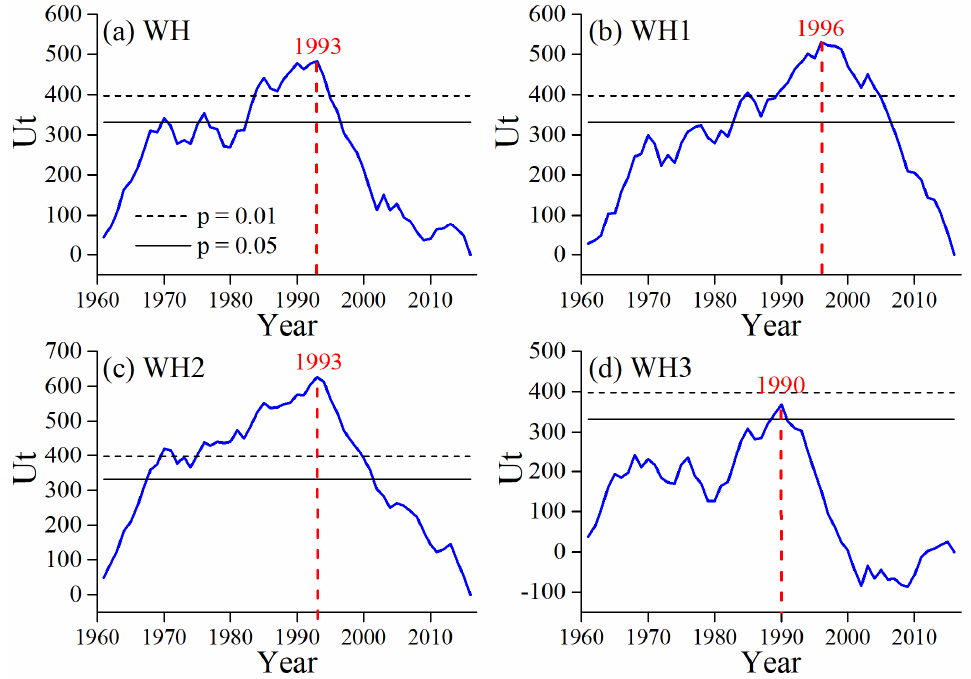
Figure 7. Ut statistic of Pettitt test used for detecting a change-point for annual runoff of ( a ) the Weihe River basin (WH) and the three sub-regions, i.e., ( b ) WH1, ( c ) WH2, and ( d ) WH3,. Table 3. Variabilities of runoff before and after change-point.